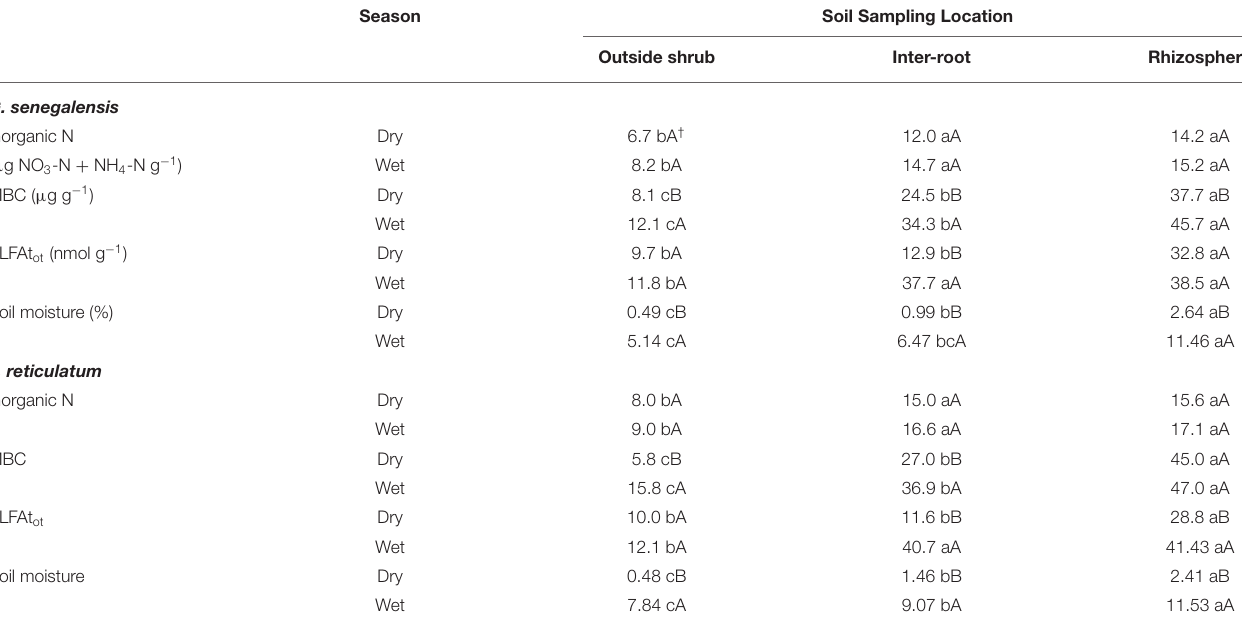
TABLE 1 | Soil inorganic N, MBC, PLFA tot and moisture of soil inside and outside the influence of G. senegalensis or P. reticulatum during the wet and dry